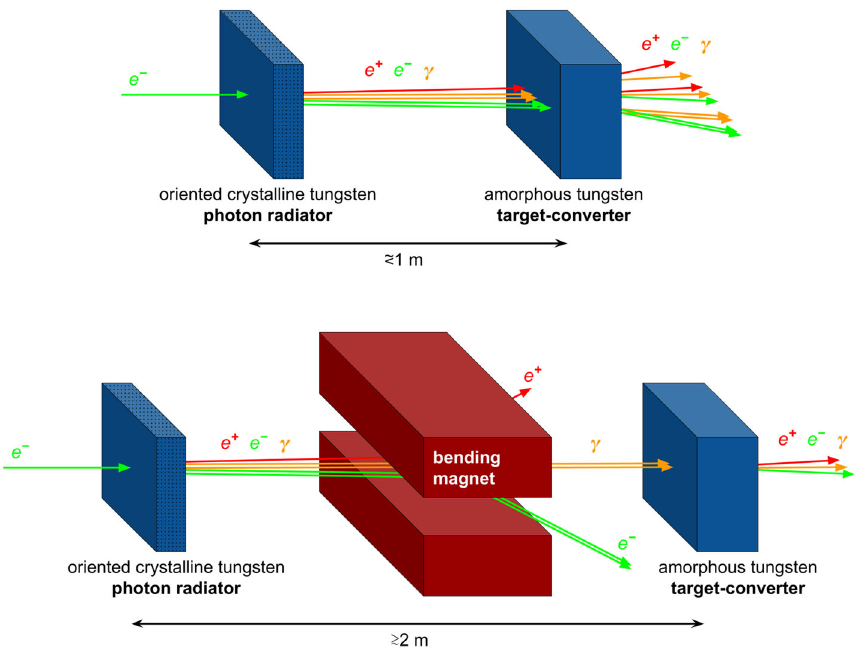
Fig. 2 Hybrid schemes for the positron source. Simple two-stage version, which features a crystalline photon radiator followed by an amorphous converter (top), and optimized version, in which a bending magnet is placed downstream with respect to the photon converter to redirect all the e + e − generated in the first stage away